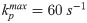
Filament distribution in the system with non-progressive gel boundary.The probability distribution of (a) detached and (b) attached filaments for the early state and also the probability distribution of (c) detached and (d) attached filaments for the late stage of the whole movement. This is the result for a system of na = 0.1 nm−1, Fe = 12 pN and kpmax=60s-1. The total number of filaments is constant and equal to 25 during the whole process. Here μ and σ are the mean value and standard deviation of a normal distribution fitted to the data.